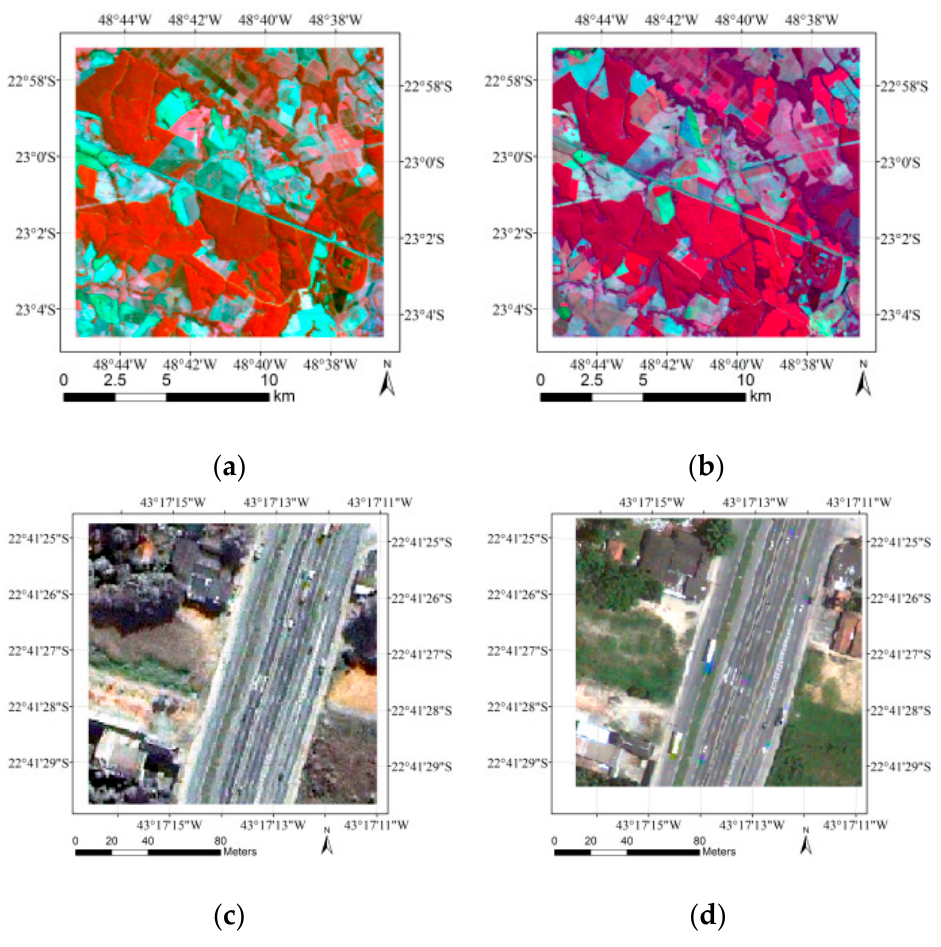
Figure 3. Images obtained from the ( a ) CBERS-2B CCD (20 m) sensor, band 2 (520–590 nm) = red, band 3 (630–690 nm) = green, band 4 (770–890 nm) = blue, ( b ) Landsat-5 TM (30 m) sensor, band 4 (760–900 nm) = red, band 3 (630–690 nm) = green, band 5 (1550–1750 nm) = blue, ( c ) Ikonos-2 MS sensor, band 4 (760–900 nm) = red, band 3 (630–690 nm) = green, band 2 (520–600 nm) = blue, and ( d ) Geoeye, band 5 (780–920 nm) = red, band 4 (655–690 nm) = green, band 3 (510–580 nm) = blue. The Ikonos-2 MS and Geoeye images were obtained through a fusion process between MS (4 m) and PAN